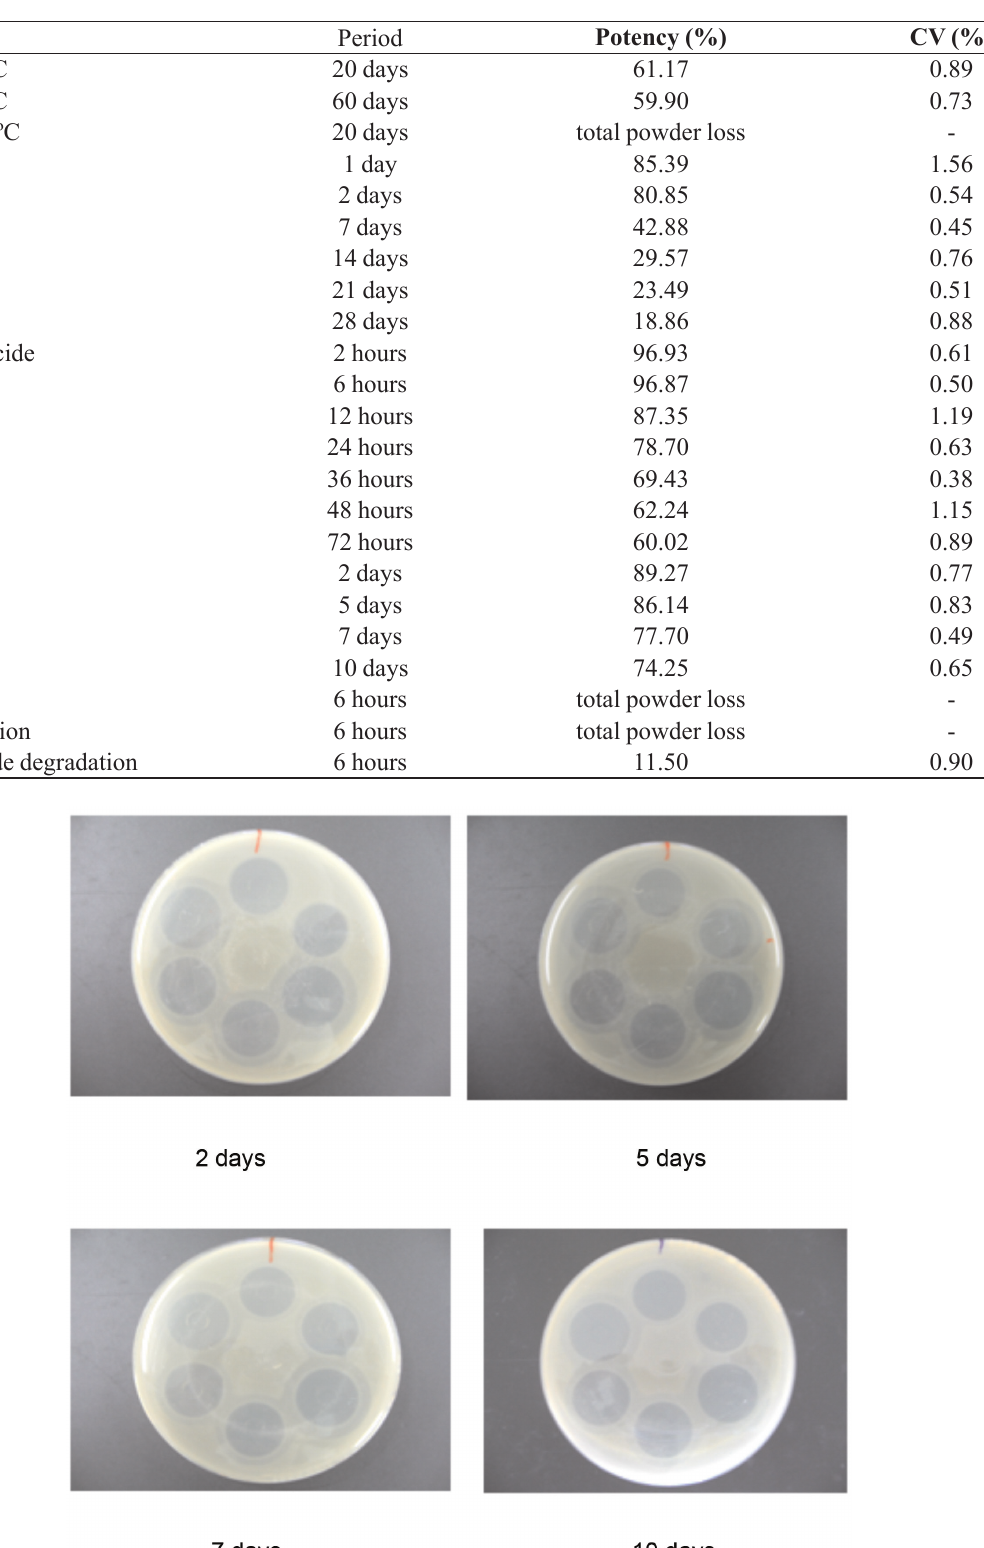
TABLE I – Experimental values obtained for the determination of azithromycin by the biodiffusion assay after stress expositions